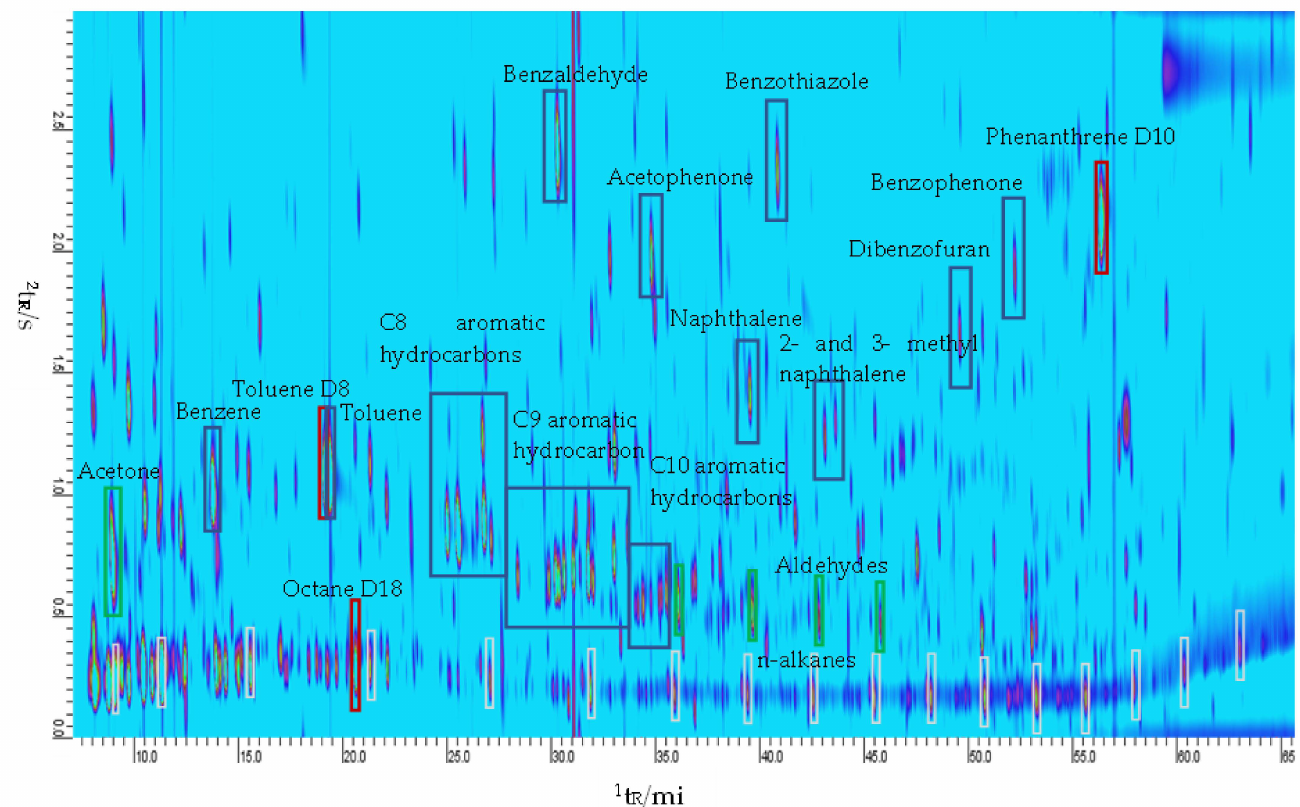
Figure 1. GCxGC-FID chromatogram of a roadside sample from Nairobi highlighting the dominant compounds observed in all samples. Added deuterated internal standards are shown in red